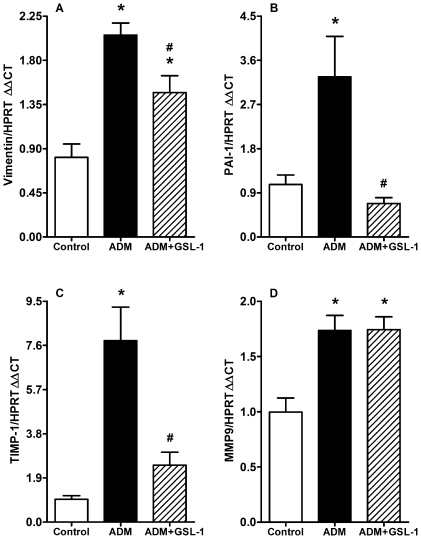
GSL-1 treatment inhibits the ADM-induced expression of fibrogenic mRNAs.BALB/c mice were injected at day 0 with 10 mg/kg of adriamycin (ADM) or treated concomitantly with ADM and 5 µg/mouse GSL-1 (ADM+GSL-1). (A) ADM mice presented increased levels of vimentin compared with control mice; vimentin was diminished in GSL-1-treated group. (B) The levels of PAI-1 transcripts significantly increased in ADM mice, in contrast with ADM+GSL-1 animals, which had levels comparable to that of the control mice. (C) TIMP-1 mRNA increased in the ADM group compared with the control and ADM+GSL-1 mice (D) MMP9 transcripts were equally increased in the ADM and ADM+GSL-1 groups compared with the control mice. These data indicate the development of ADM-induced FSGS with renal remodeling. * p<0.05 vs. control; # p<0.05 vs. ADM.